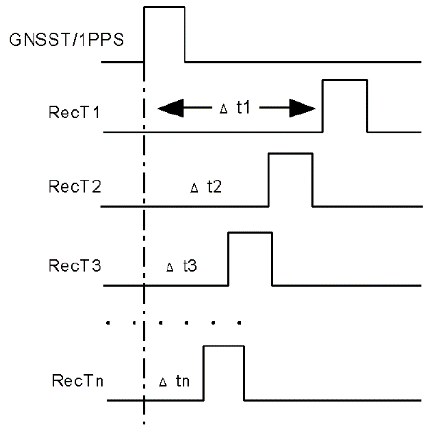
Figure 1. Clock-steering processing of the receiver time.